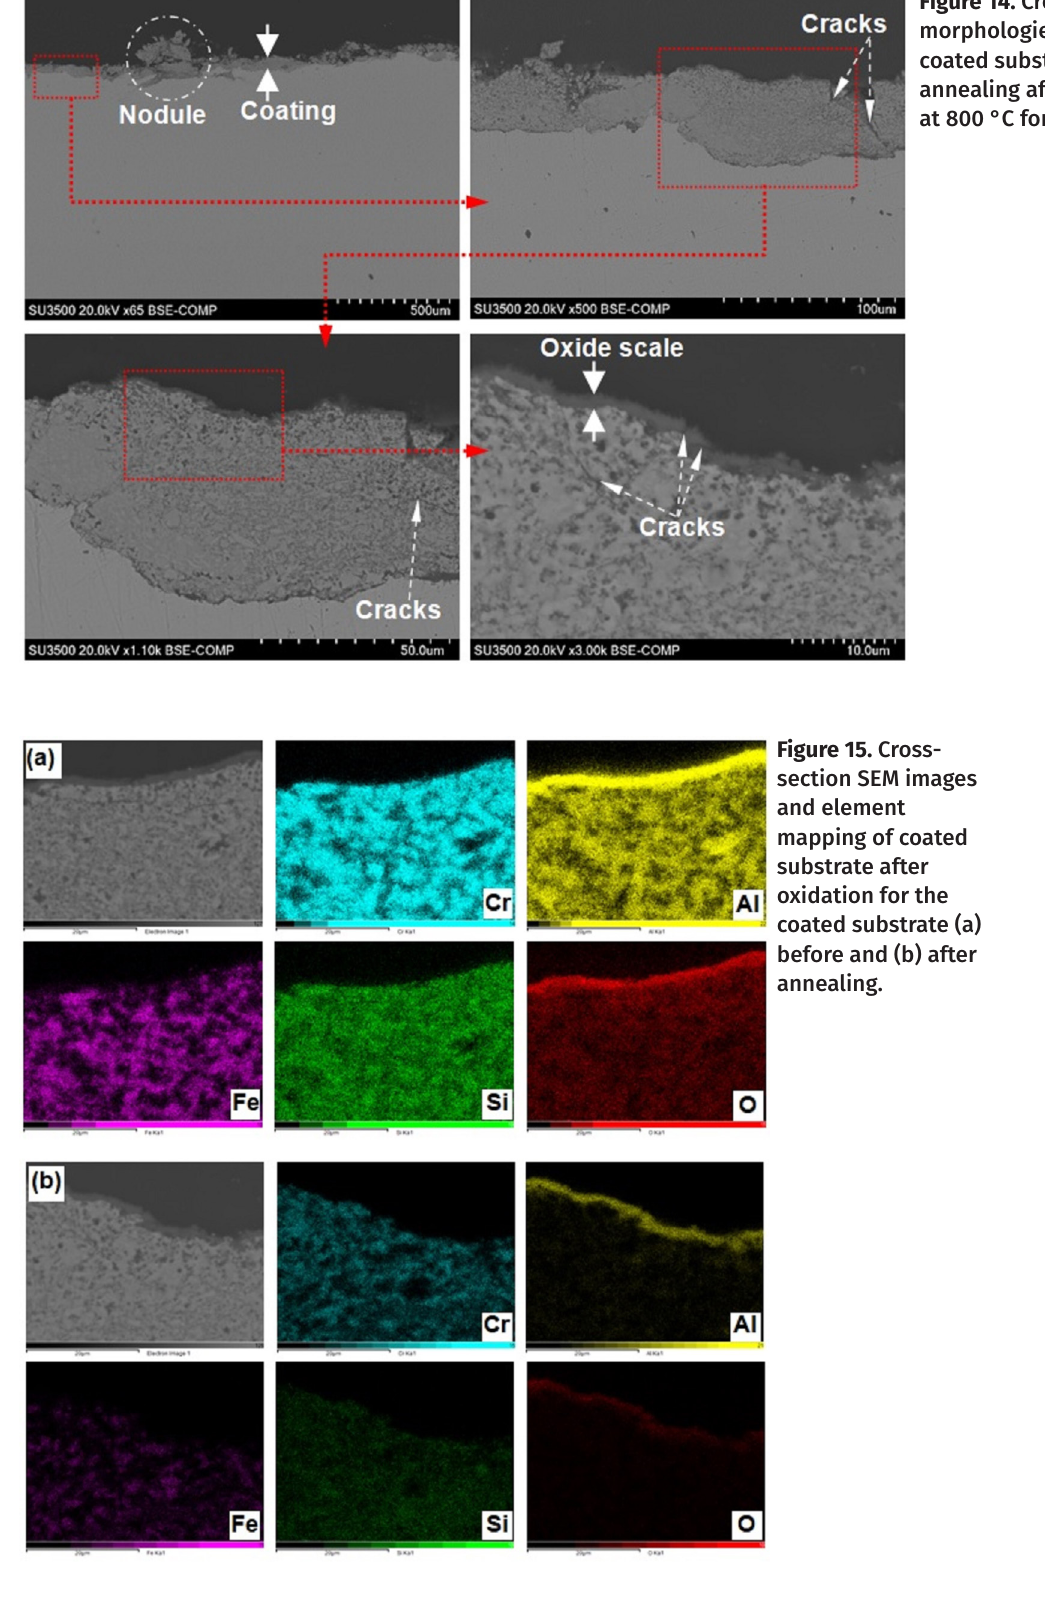
Figure 14. Cross-section morphologies of the coated substrate with annealing after oxidation at 800 °C for 8 cycles.